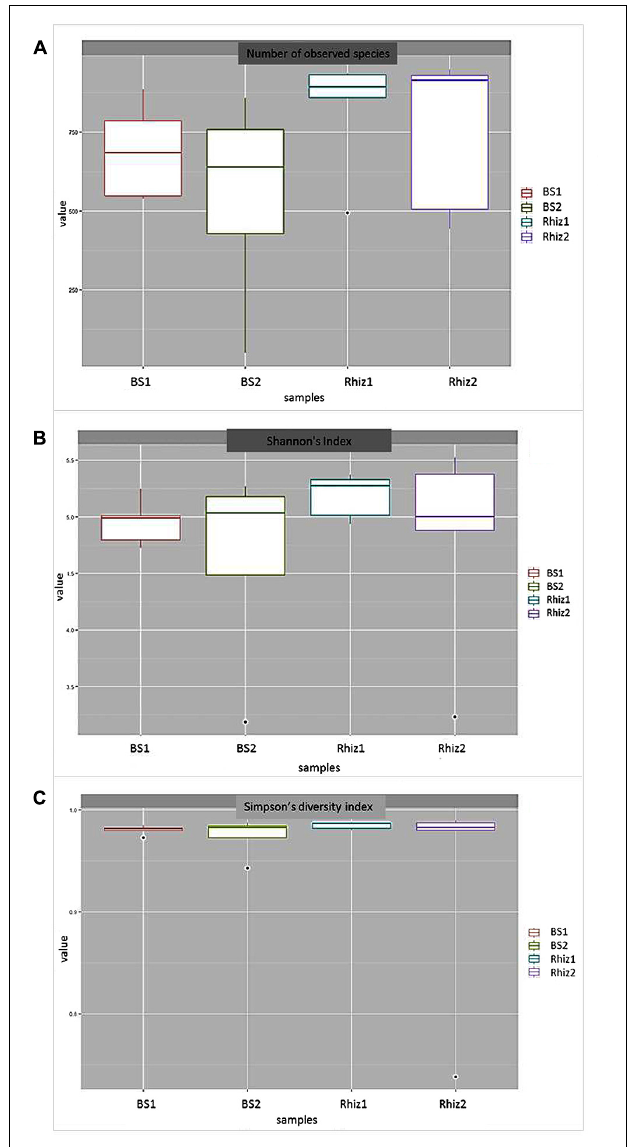
FIGURE 2 | (A) Number of bacterial species detected in bulk soil and rhizosphere of Vitis vinifera at the two sampling times. (B) Biodiversity (Shannon’s Index) of the microbial community found in bulk soil and the rhizosphere at the two sampling times. (C) Simpson’s Diversity Index of the microbial community found in bulk soil and the rhizosphere at the two sampling times.